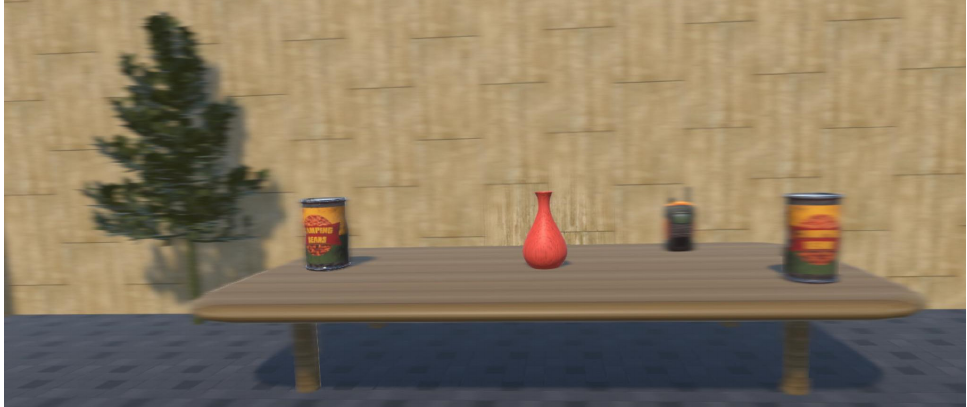
Figure 7. Example of an output from the foveated depth-of-field blur